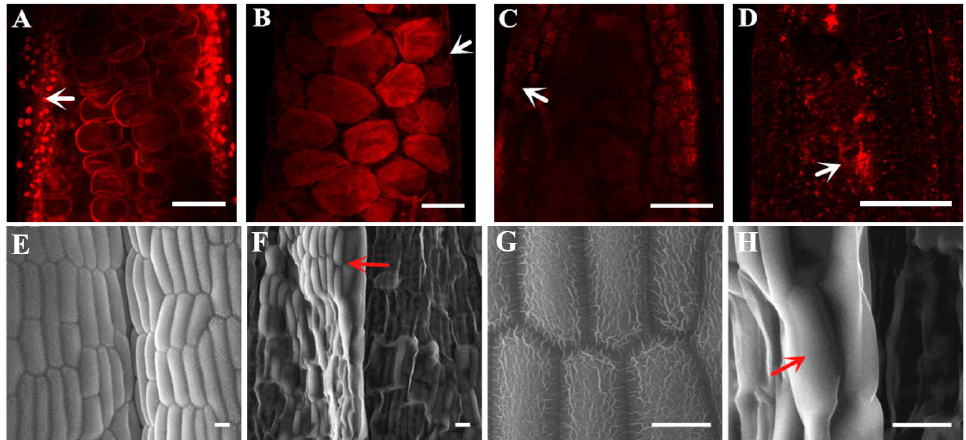
Figure 3. Defective development of the ms305 anther wall. Laser scanning confocal microscopy analysis of fertile sibling ( A , B ) and ms305 anther ( C , D ), ( A ) Microspore stage of fertile sibling; ( B ) Mature pollen stage of fertile sibling; ( C ) Degraded anther of ms305 , no cell nucleuses were observed; ( D ) Aborted anther of ms305 . Scale bars = 100 µ m. SEM analysis of the anther surface of fertile sibling ( E ) and ms305 ( F ), × 400; ( G ) Epidermal cell surface of fertile sibling anther with reticulate pattern, × 1500; ( D ) Epidermal cell surface of ms305 was smooth without reticulate pattern, × 1500. Scale bars = 20 µ m.